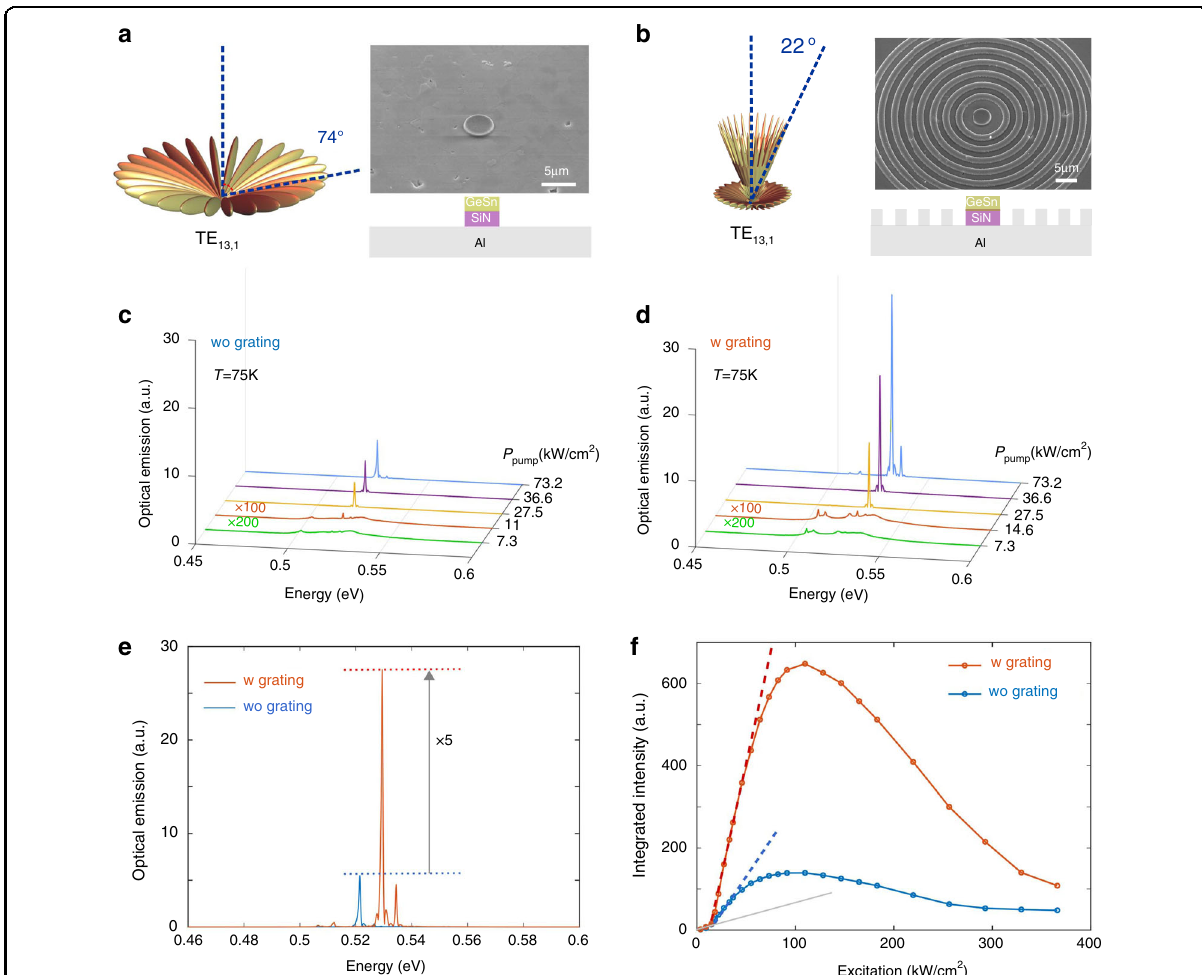
Fig. 7 Vertical out-coupling of GeSnOI mesa lasing WGM. a , b SEM images and calculated emission patterns of 4 µm diameter GeSnOI mesas without and with Al circular grating (7 rings spaced by 3 µm with a duty cycle of 50%). Calculations have been performed with an aperiodic Fourier modal method dedicated to body-of-revolution objects 45 . c , d Power-dependent spectra without and with Al circular grating. e Spectra with and without grating for a 73.2 kW/cm 2 excitation density. f L – L curves of GeSnOI lasers with and without